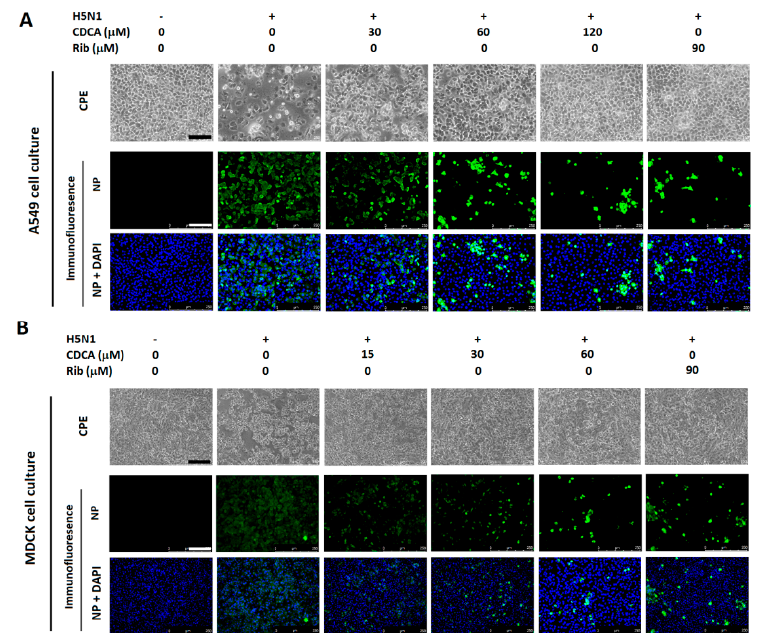
Figure 2. CDCA inhibited H5N1 replication in A549 and MDCK cell cultures. A549 ( A ) or MDCK ( B ) cells grown in 96-well plates were infected with H5N1 virus (0.1 MOI) for 1 h at 37 °C and then cultured in fresh medium containing various concentrations of CDCA. At 48 hpi, cytopathic effect (CPE) was observed under microscopy (upper panels of A and B ). Then the cells were fixed with paraformaldehyde and the viral NP expression was detected by indirect immunofluorescence assay (IFA). Representative IFA images for A549 ( A ) and MDCK ( B ) cells from three independent experiments were shown. Scale bar: 125 µ m. Molecules 2018 , 23 , x FOR PEER REVIEW